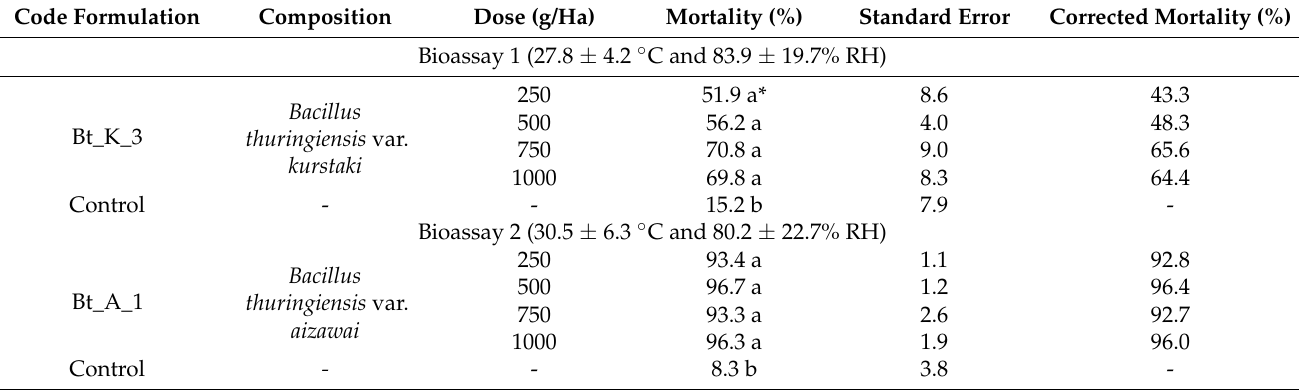
Table 3. Mean mortality of Stenoma impressella larvae obtained with two commercial formulations of Bacillus thuringiensis at different doses under field conditions, seven days after spraying. Code